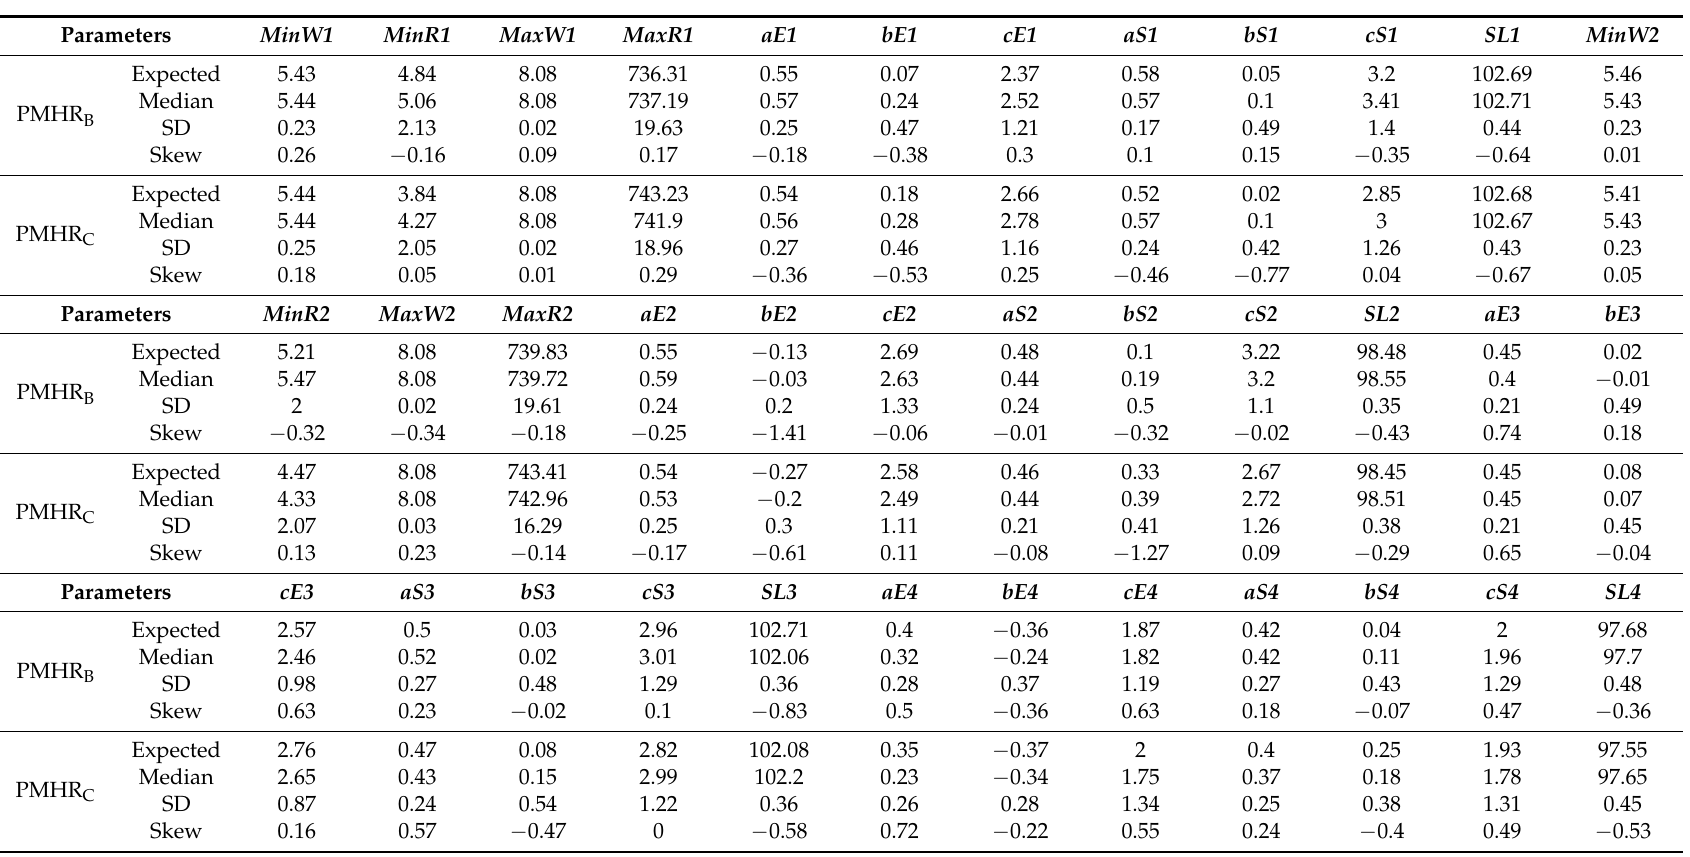
Table 4. Statistical Analysis for the Parameters of Counterbalance